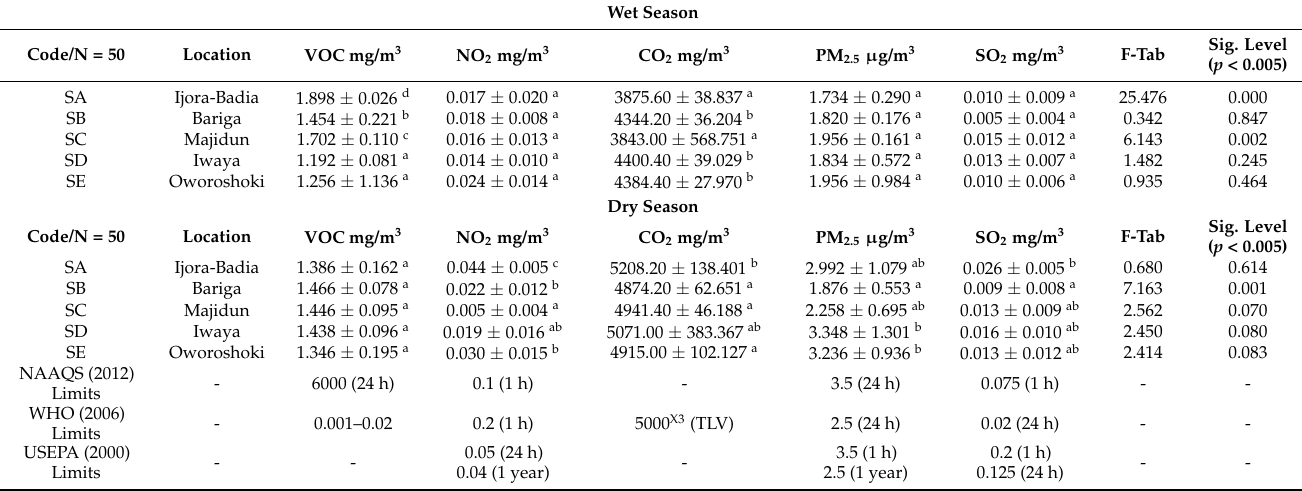
Table 1. Mean concentrations of the air quality parameters (N = 250) (wet and dry seasons). Wet